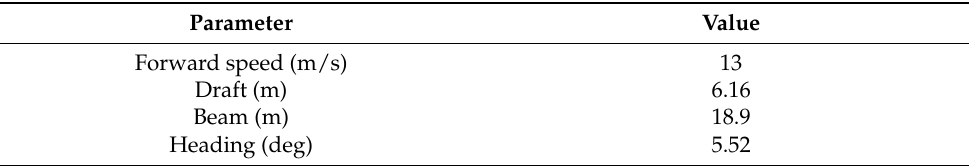
Table 4. Surface ship parameters.